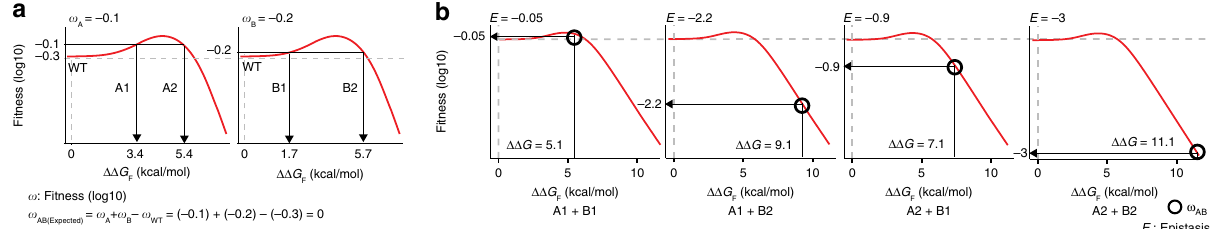
Fig. 6 Unpredictable double mutant phenotypes. a For ‘ peaked ’ expression- fi tness functions such as that shown in Fig. 5b, the same change in fi tness can be caused by two different changes in folding free energy. b For a pair of single mutant phenotypes there can therefore be up to four possible double mutant